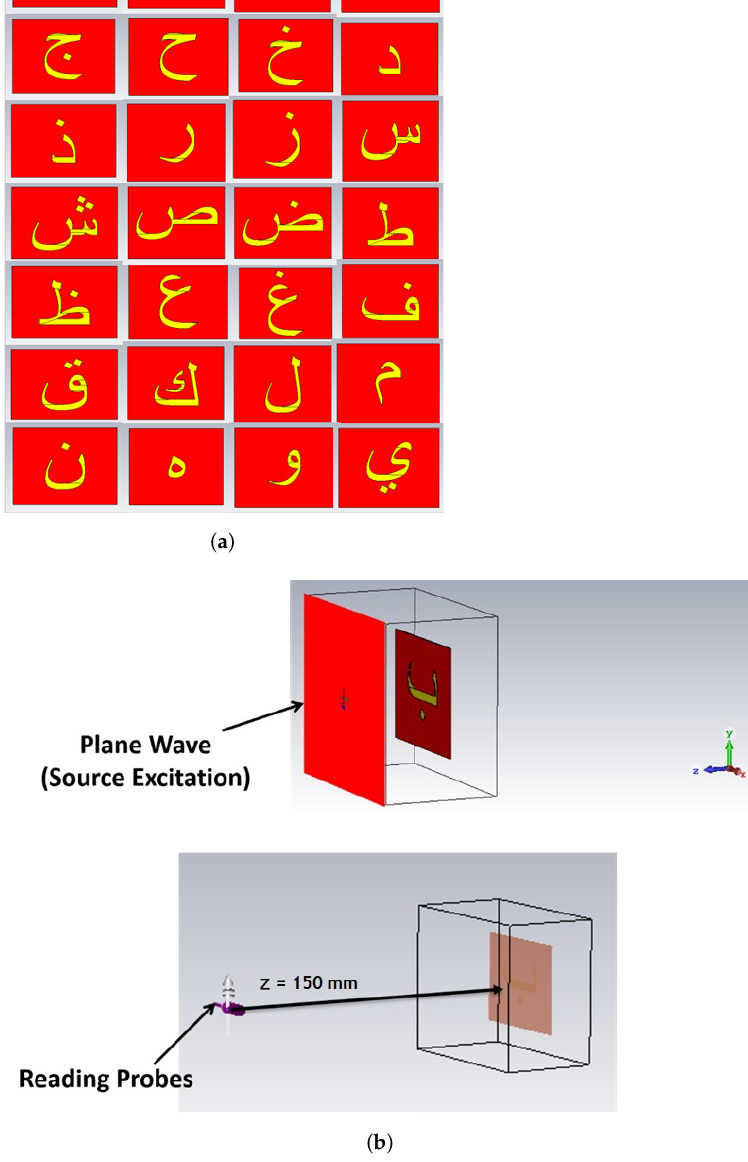
Figure 3. Realized tags and simulation setup: ( a ) All designed Arabic letter tags with Arial font size of 28 mm; ( b ) Tag simulation analysis setup in CST MWS using FDTD method.